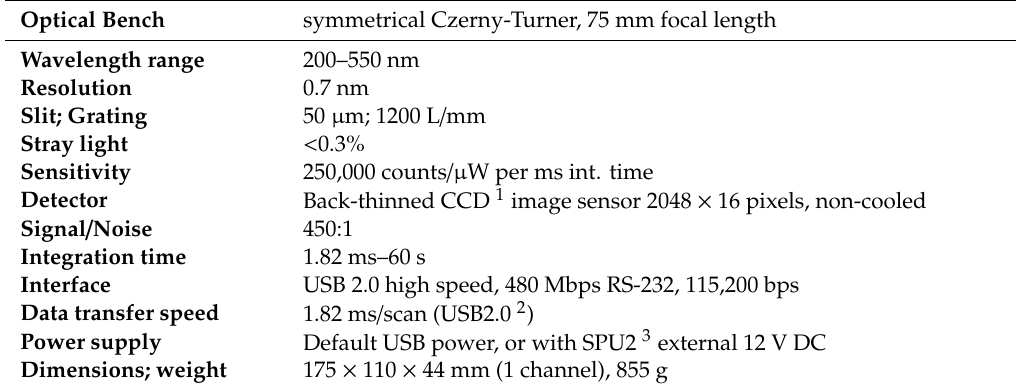
Table 2. The main technical characteristics of the Avantes UV–Vis